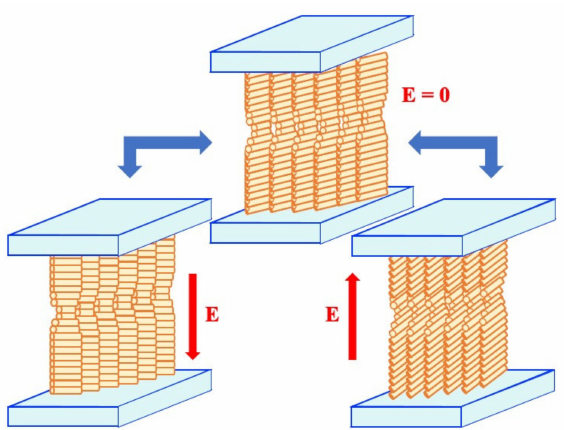
Figure 17. The expected initial molecular stacking configuration with slightly twisted structure. The smectic liquid crystal molecules stack, slightly twisted between the two substrates. The initial twisting structure may change with applied electric field